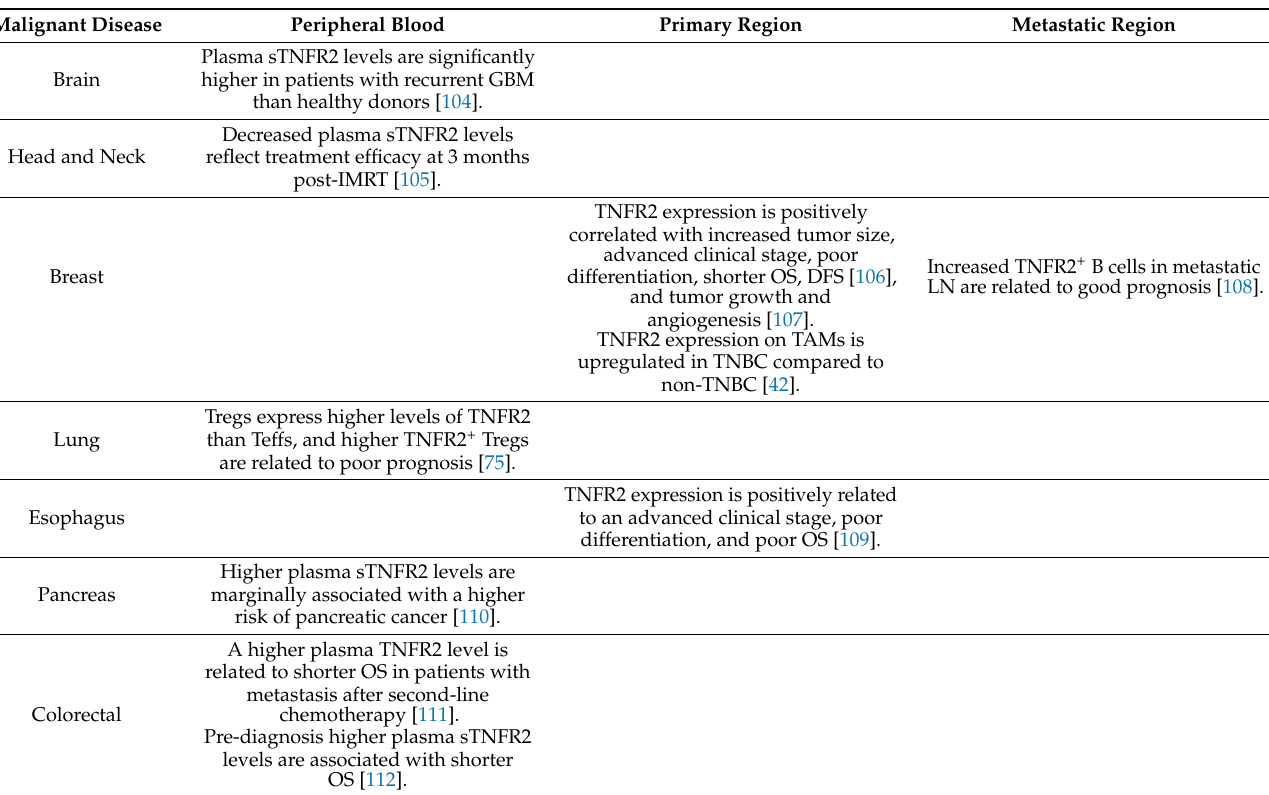
Table 2. Summary of Human Studies of TNFR2 in Malignant